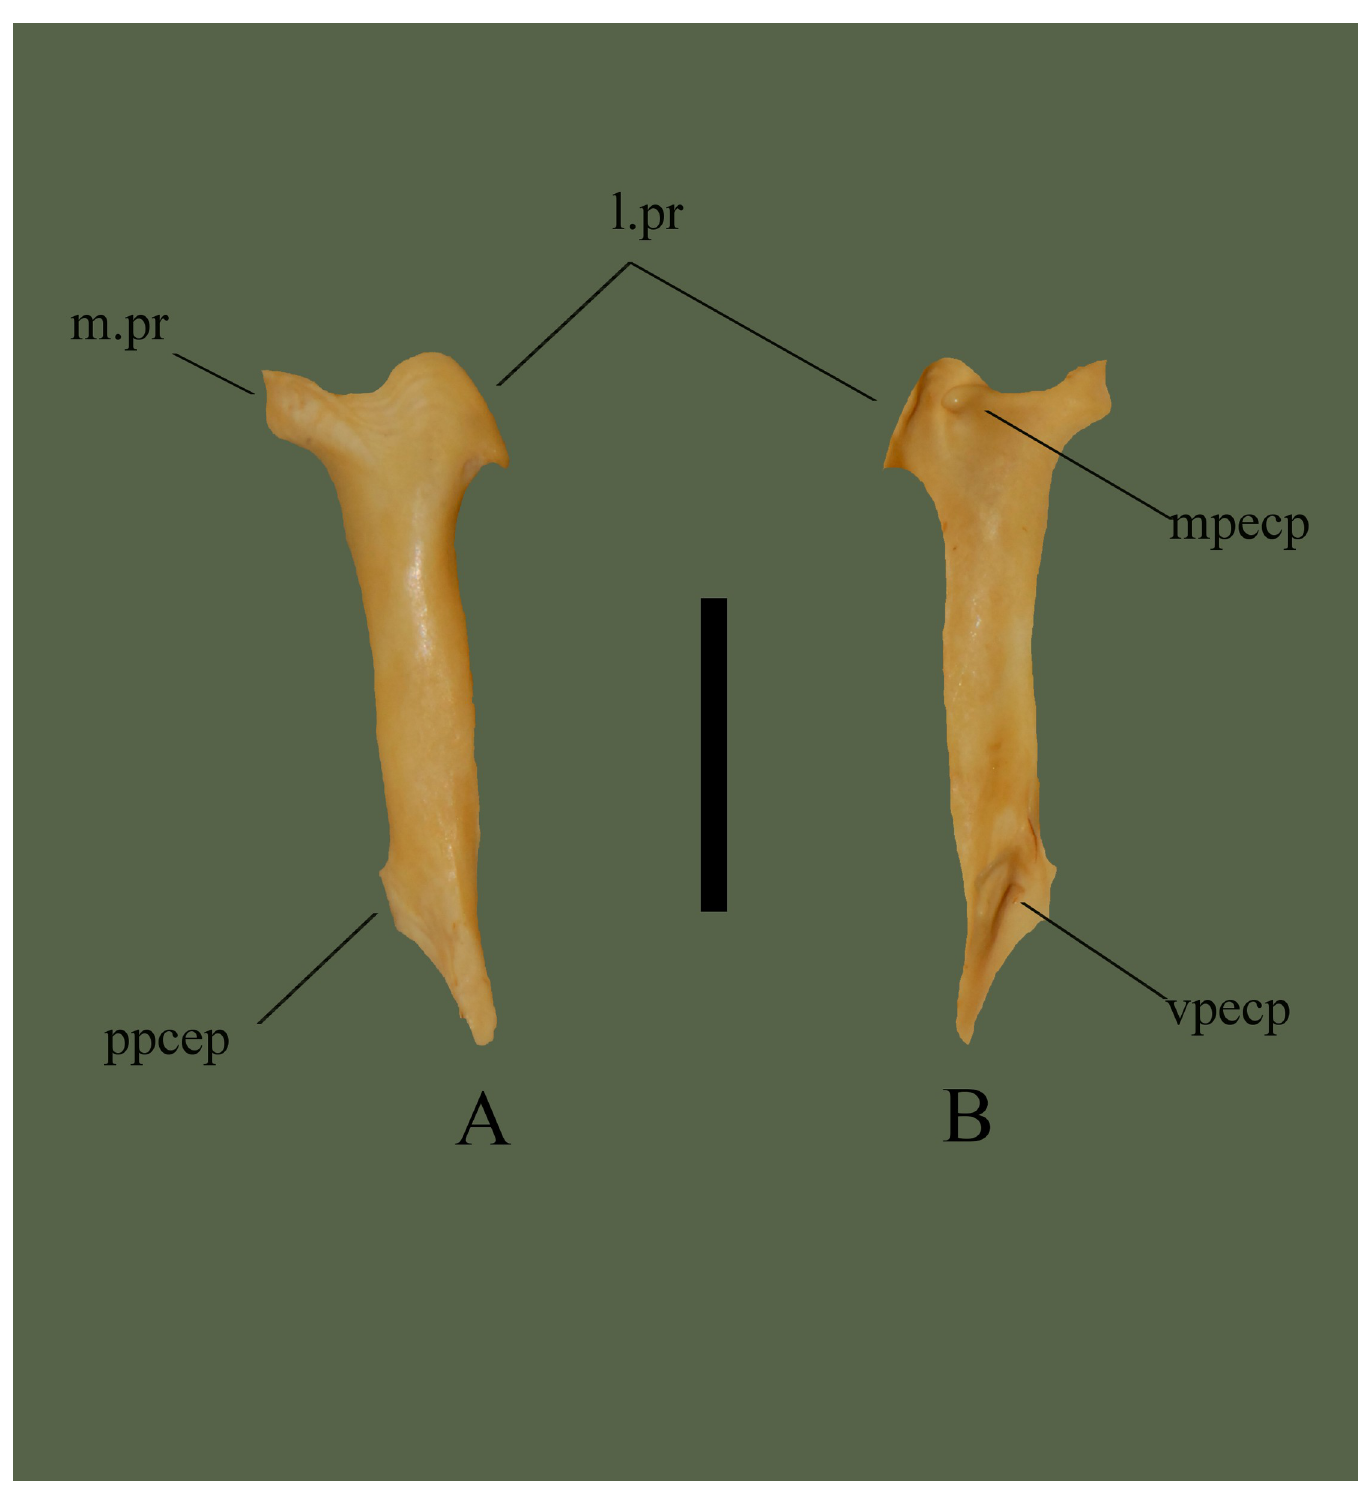
Fig 5. Right ectopterygoid (ETVP 3295) in dorsal (A) and ventral (B) view . Anterior is to the top. Scale bar = 10 mm. Abbreviations: l.pr = lateral process; m. pr = medial process; mpecp = maxillary process of ectopterygoid; ppecp = pterygoid process of ectopterygoid; vpecp = ventral process of ectopterygoid.